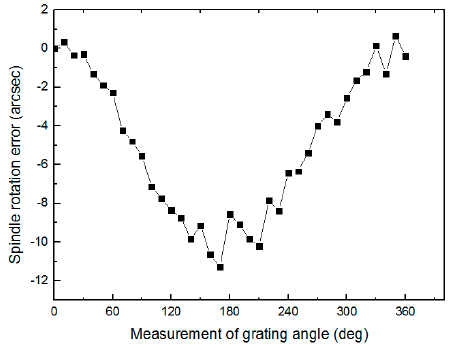
Figure 10. Measured error of the spindle’s rotation angle.